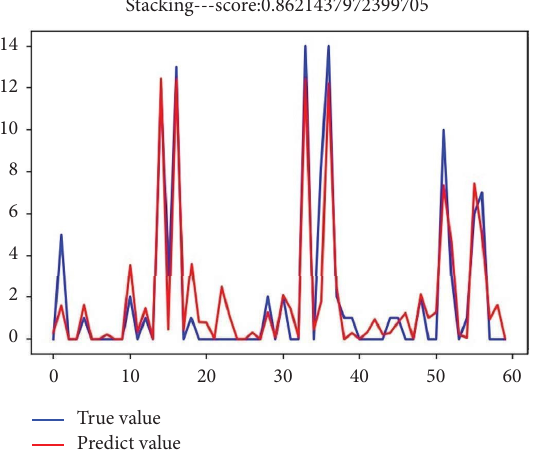
Figure 22: Prediction results of the stacking ensemble model.